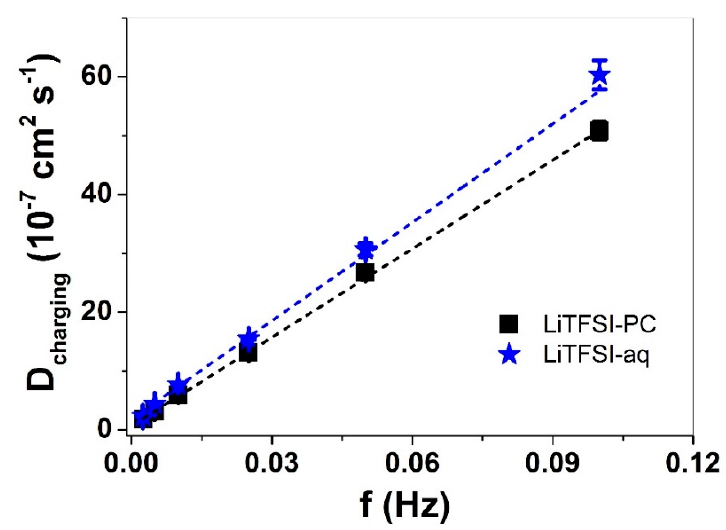
Figure 6. Diffusion coefficients D in Cell-CNT fibers in LiTFSI-PC ( ■ ) and LiTFSI-aq ( ★ ) electrolytes against frequency upon charging. The linear fits (dashed) are shown here only for orientation.